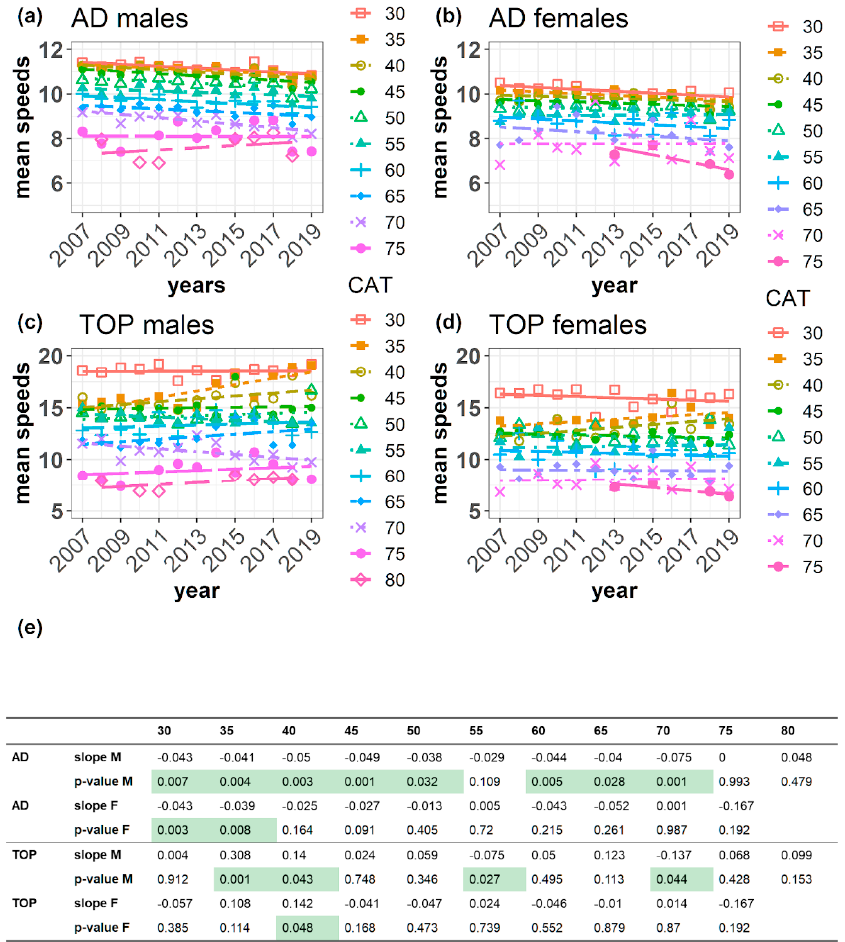
Figure 2. Analysis of the running speed of participants in the 2007–2019 VM editions: ( a – d ) Regression lines for athletes’ mean speeds by year in each age category. ( a , c ) Regression lines for AD and TOP male athletes, respectively. ( b , d ) Regression lines for AD and TOP female athletes, respectively. ( e ) Slope coefficients and p -values computed by linear regression on speeds by age category and gender in the 2007–2019 VM editions. CAT = age category, M = male, F = female, 30–80 = age category. The p -values < 0.05 are considered statistically significant, and p values < 0.001 are considered highly significant.